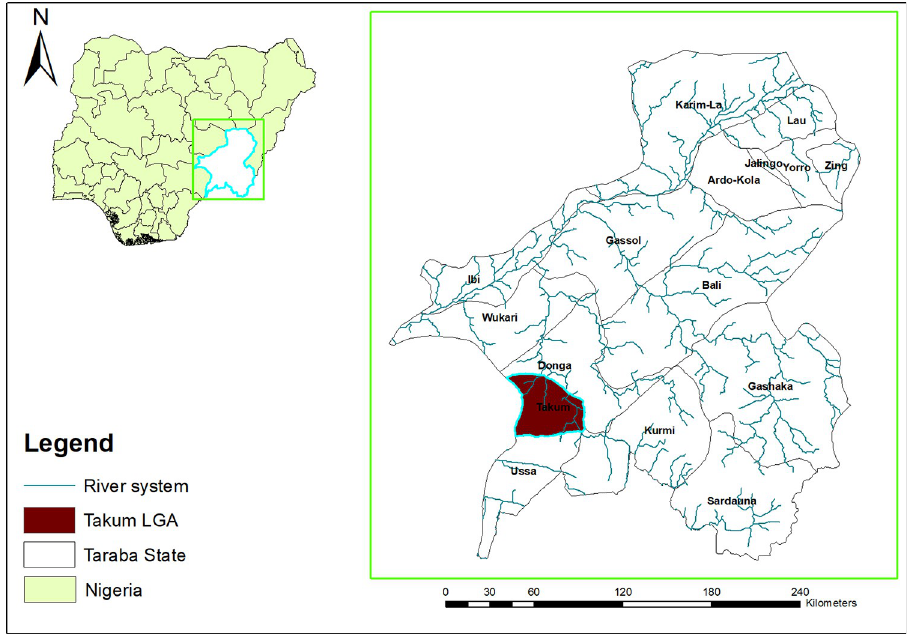
Fig 2. Map of Taraba State showing the study LGA. Source: The authors using their primary data in ArcGIS software created this map. Permission: The authors give permission to re-use this map.